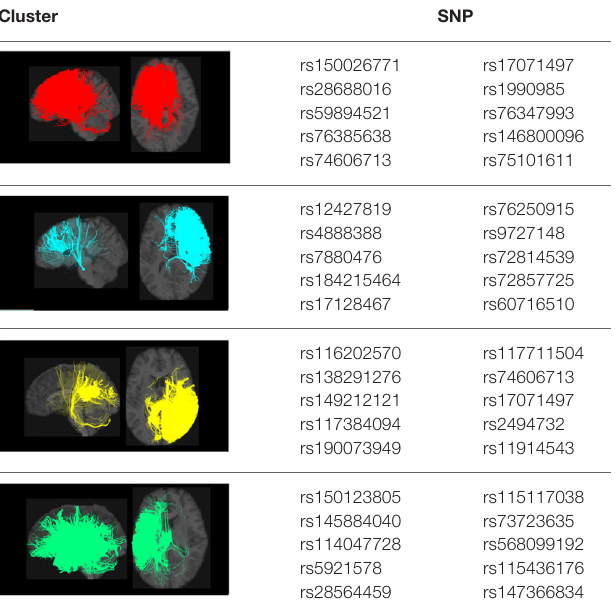
TABLE 1 | Visualization of the four clusters and their corresponding top selected single nucleotide polymorphisms (SNPs).